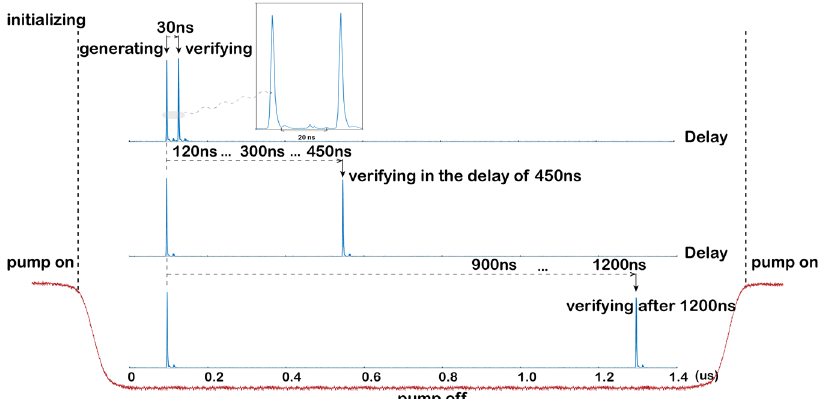
(cid:4) (cid:5) (cid:4) to